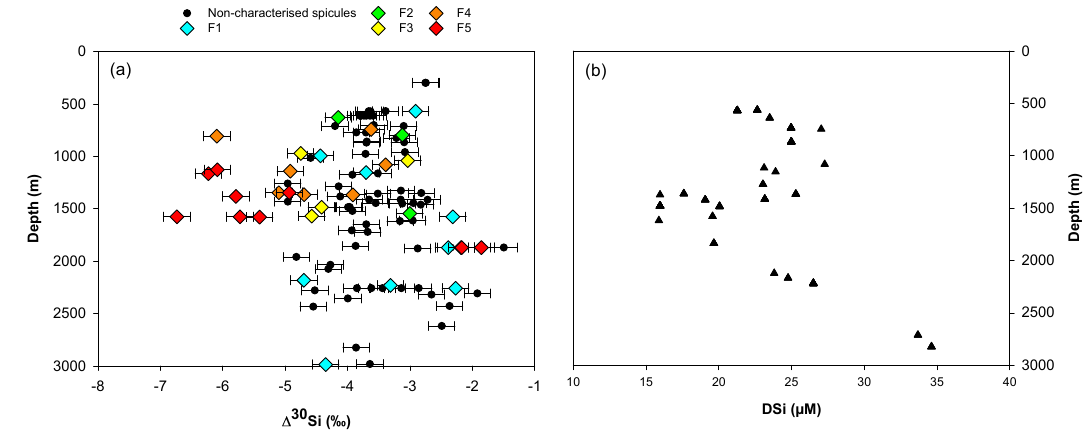
Figure 7. (a) Apparent Si isotopic fractionation ( δ 30 Si) by sponges against depth from this study. Coloured diamonds represent the degree of fusion from loose spicules (blue), net-like (green), additional silica coating (yellow), dictyonal framework (orange) and dense dictyonal framework (red). (b) DSi concentration in the equatorial Atlantic from EBA, EBB, VEM, VAY and